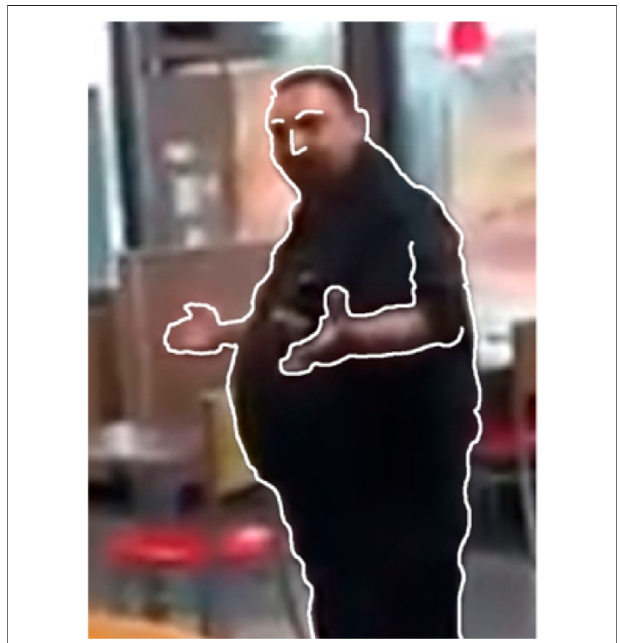
FIGURE 1 | Two-handed, palm-up, open-arm, lateral gesture (taken from example (8)